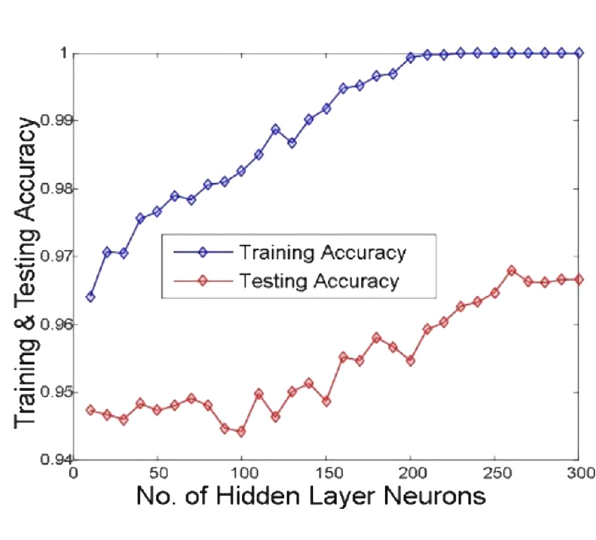
Figure 7: Hidden neurons versus training & testing accuracy (TLBO-ELM).